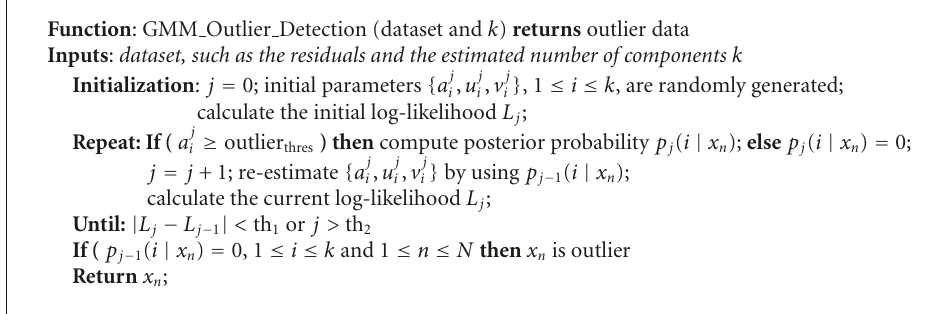
Algorithm 1: The proposed outlier detection